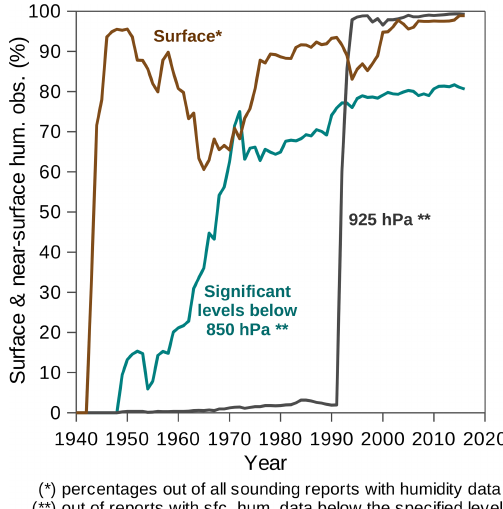
Figure 2. Percentage of humidity observations: at the surface level out of all humidity soundings in each year; at 925hPa, out of the soundings with surface data below that level; and at any nonstandard level – excluding 925hPa, irrespective of the year – between the surface and the 850hPa level, whenever this is above the